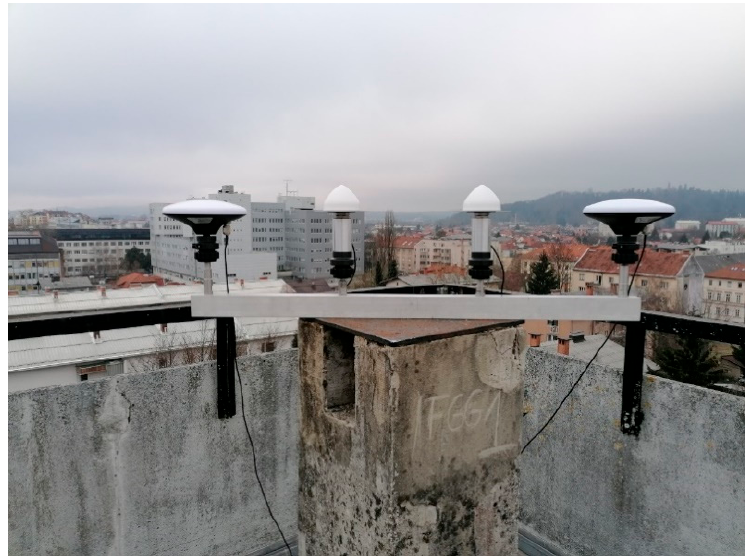
Figure 3. Low-cost uncalibrated antennas with the 4-point metal arm.